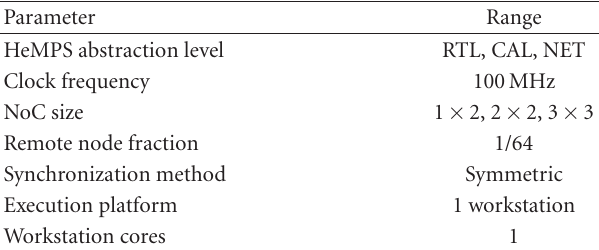
Table 2: Abstraction benchmark